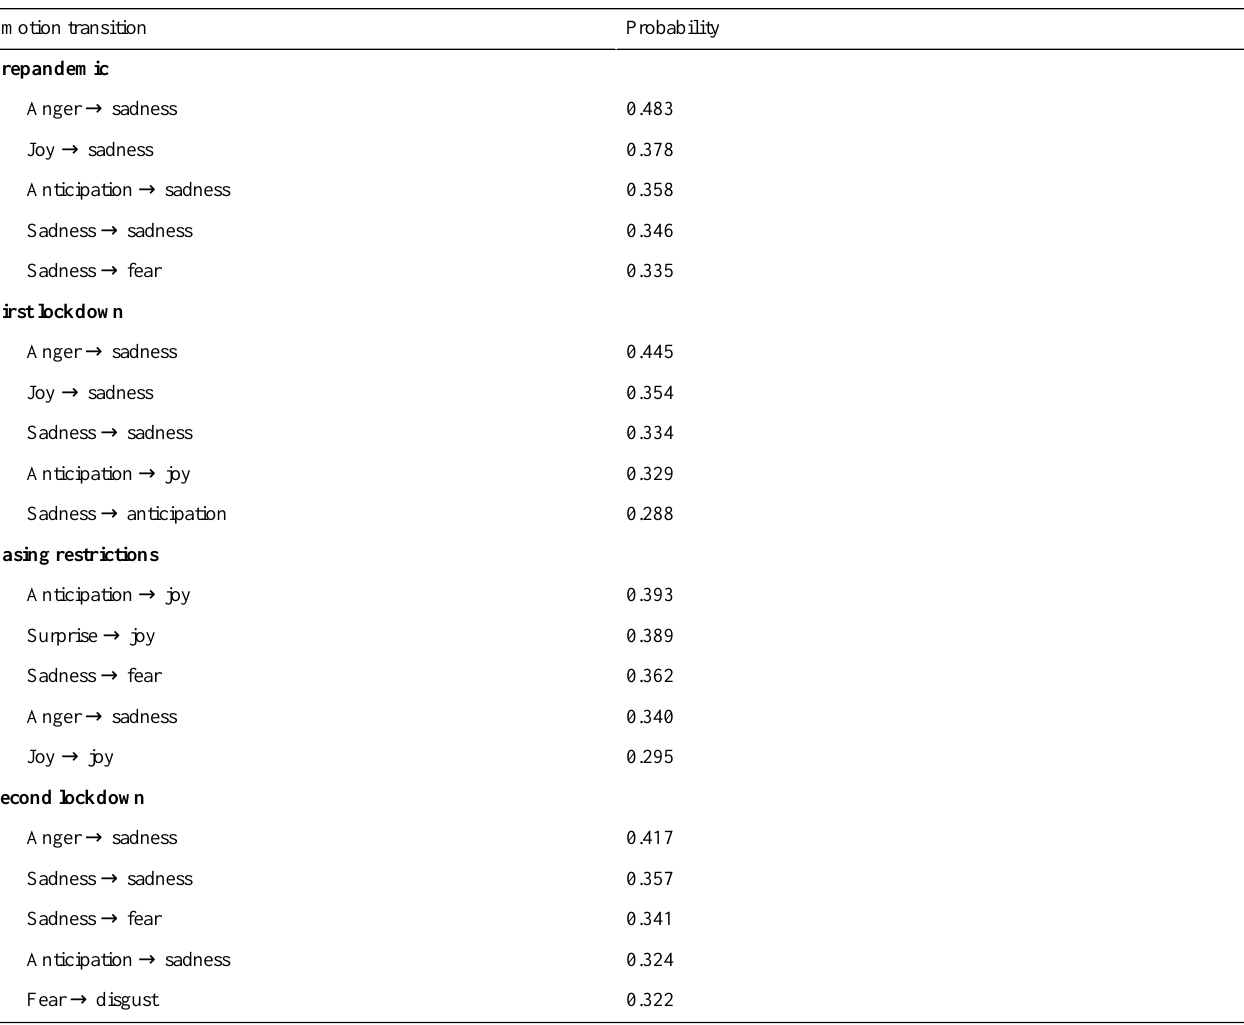
Table 4. Top five emotion transitions and probabilities for each pandemic